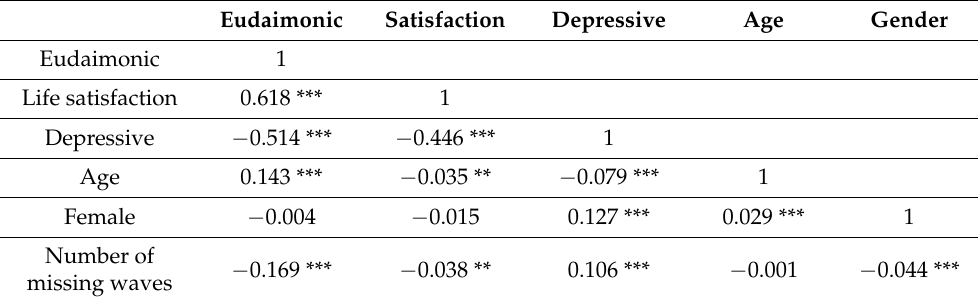
Table 2. Correlation Matrix.